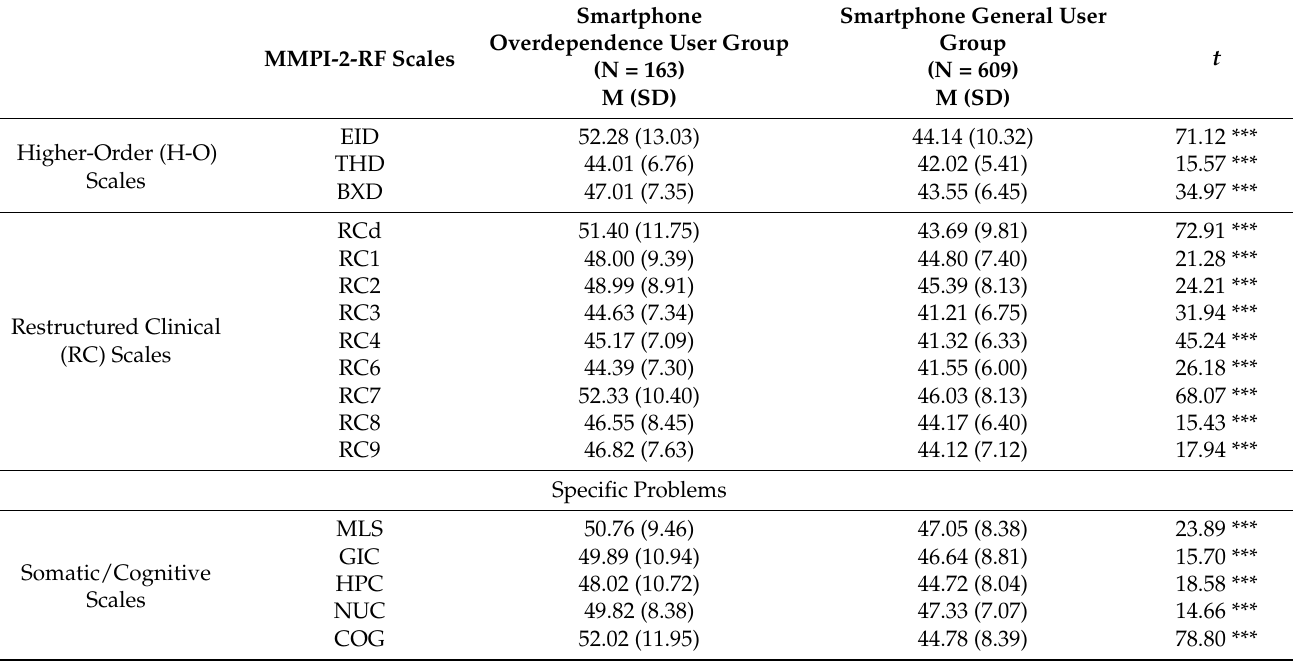
Table 2. Comparison of the mean MMPI-2-RF scale scores of the smartphone overdependence group and the general user